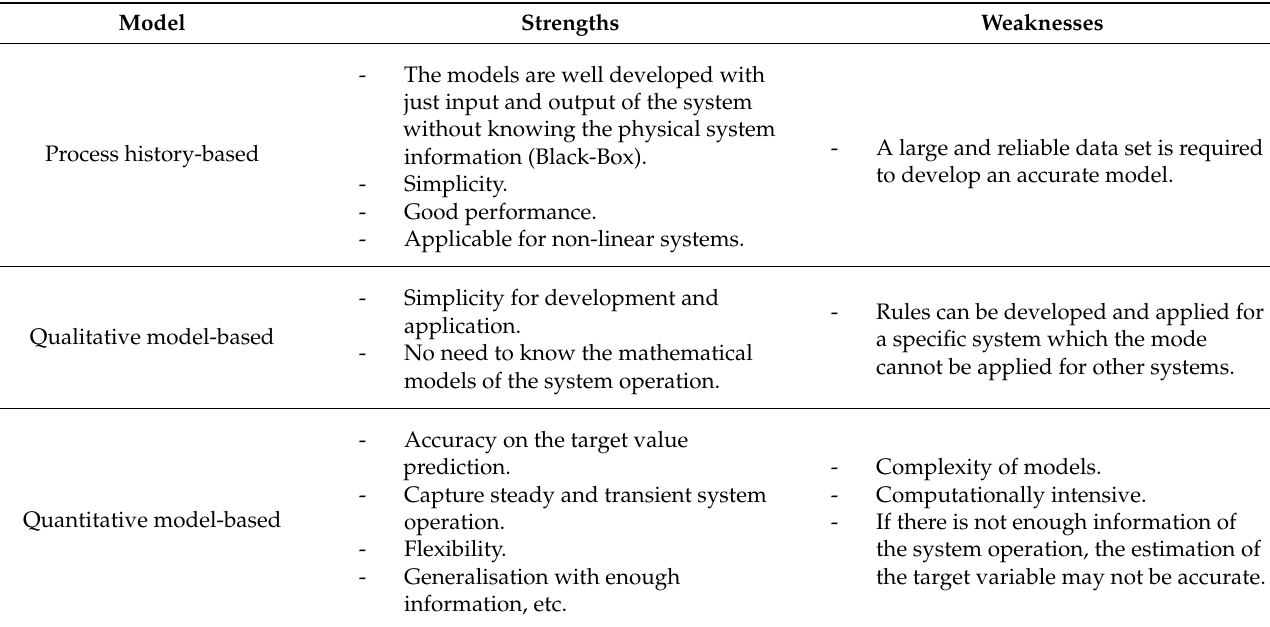
Table 1. Strengths and weaknesses of FDD